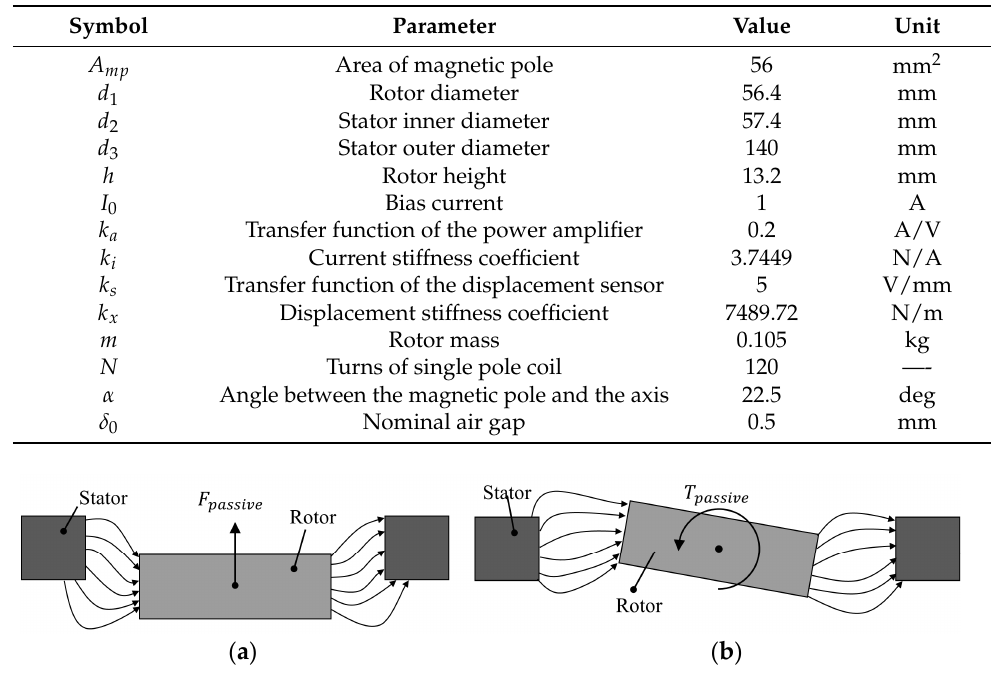
Figure 2. Passive stabilization: ( a ) Axial direction; ( b ) tilting directions.